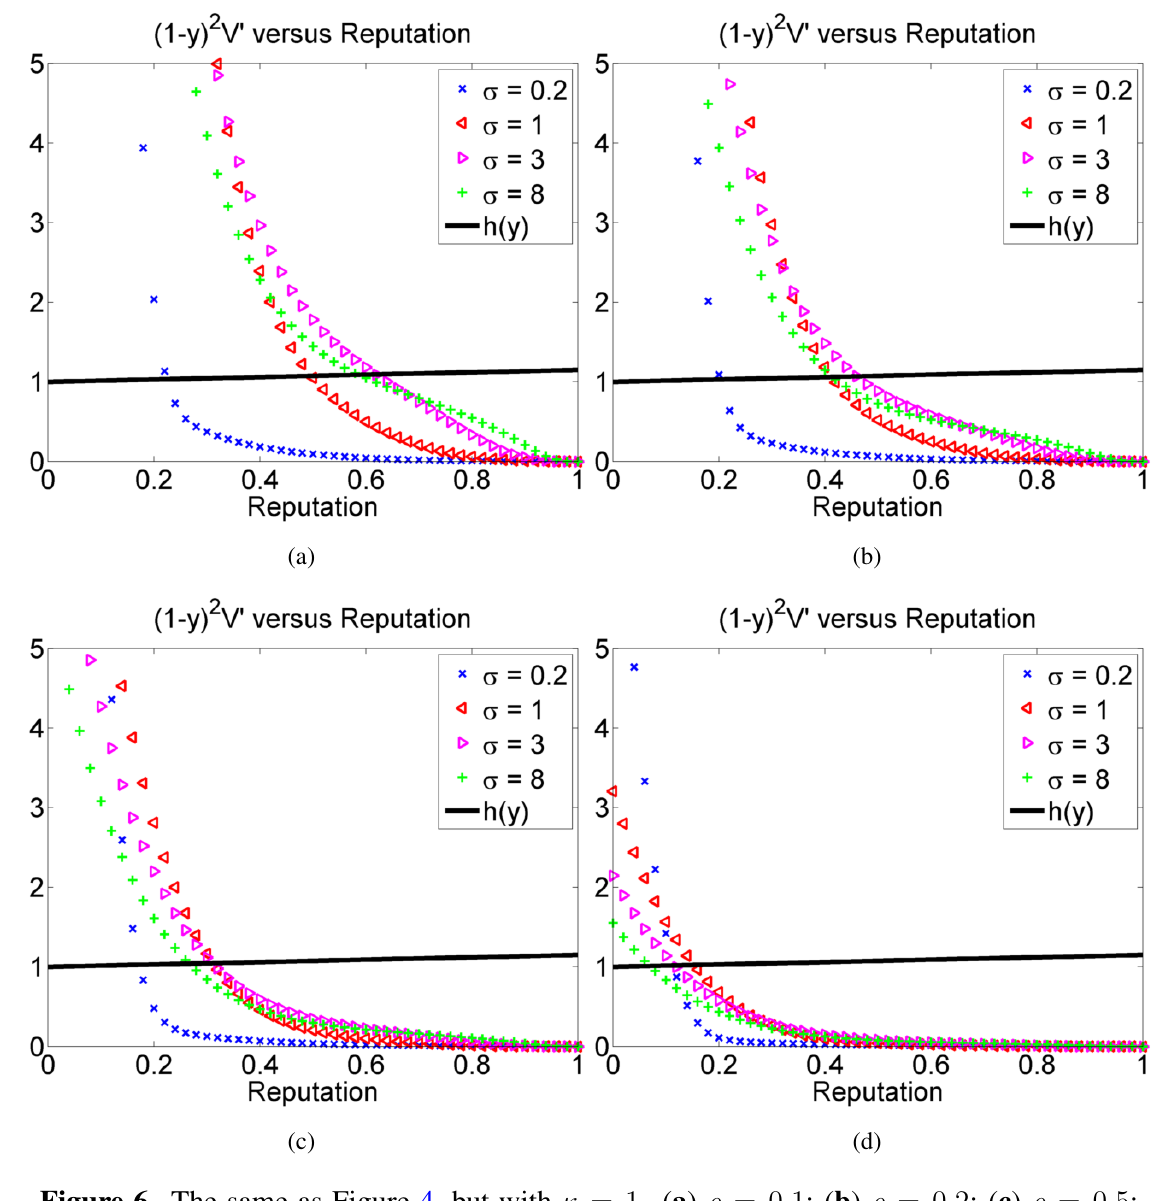
Figure 6. The same as Figure 4, but with κ = 1 . ( a ) ρ = 0 . 1 ; ( b ) ρ = 0 . 2 ; ( c ) ρ = 0 . 5 ; ( d ) ρ = 2 . 0